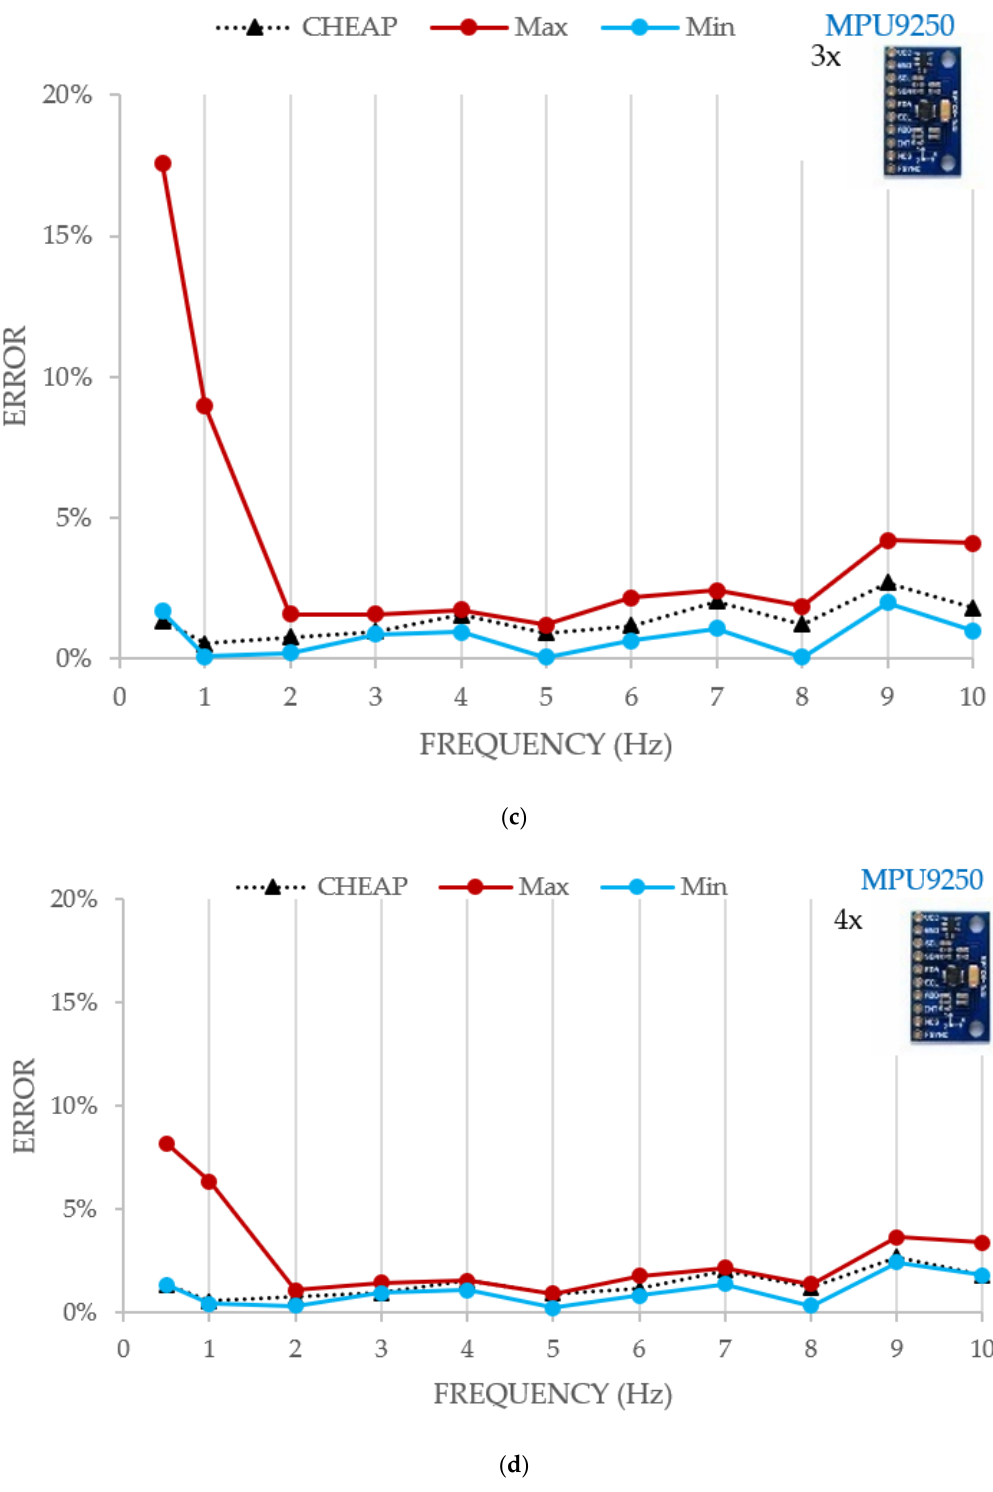
Figure 5. Estimated MA error for different number of sensors: one sensor ( a ), two sensors ( b ), three sensors ( c ), four sensors ( d ).